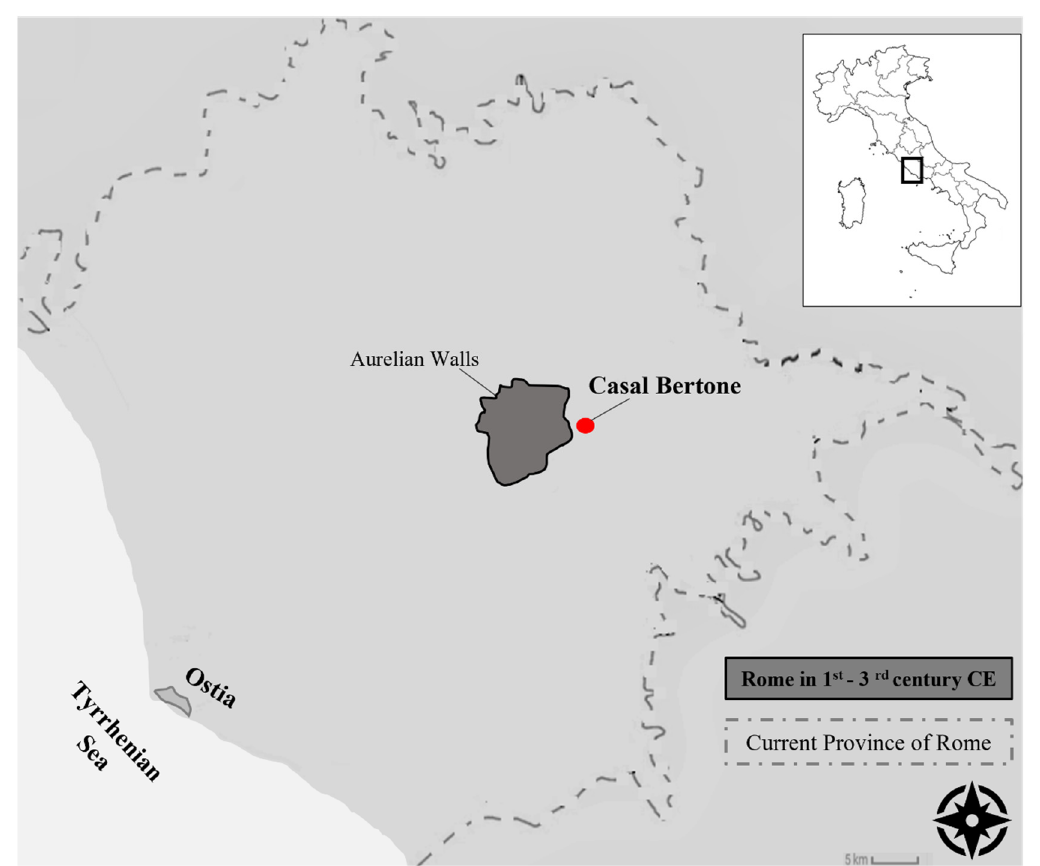
Figure 1. The red dot marks the geographic location of Casal Bertone. The dark area represents the Roman borders embodied by the Aurelian walls in the third century CE.